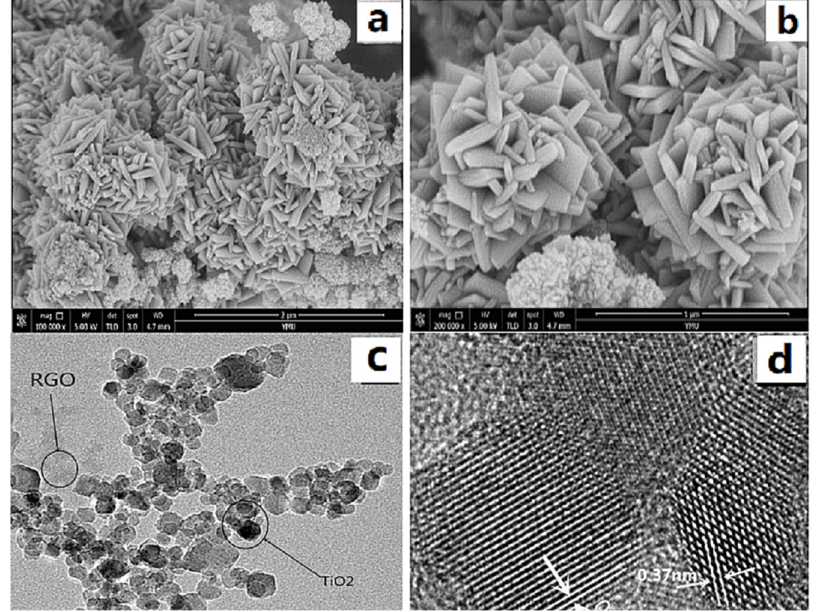
Figure 2. ( a , b ) SEM and ( c , d ) TEM images of GO/TiO 2 .